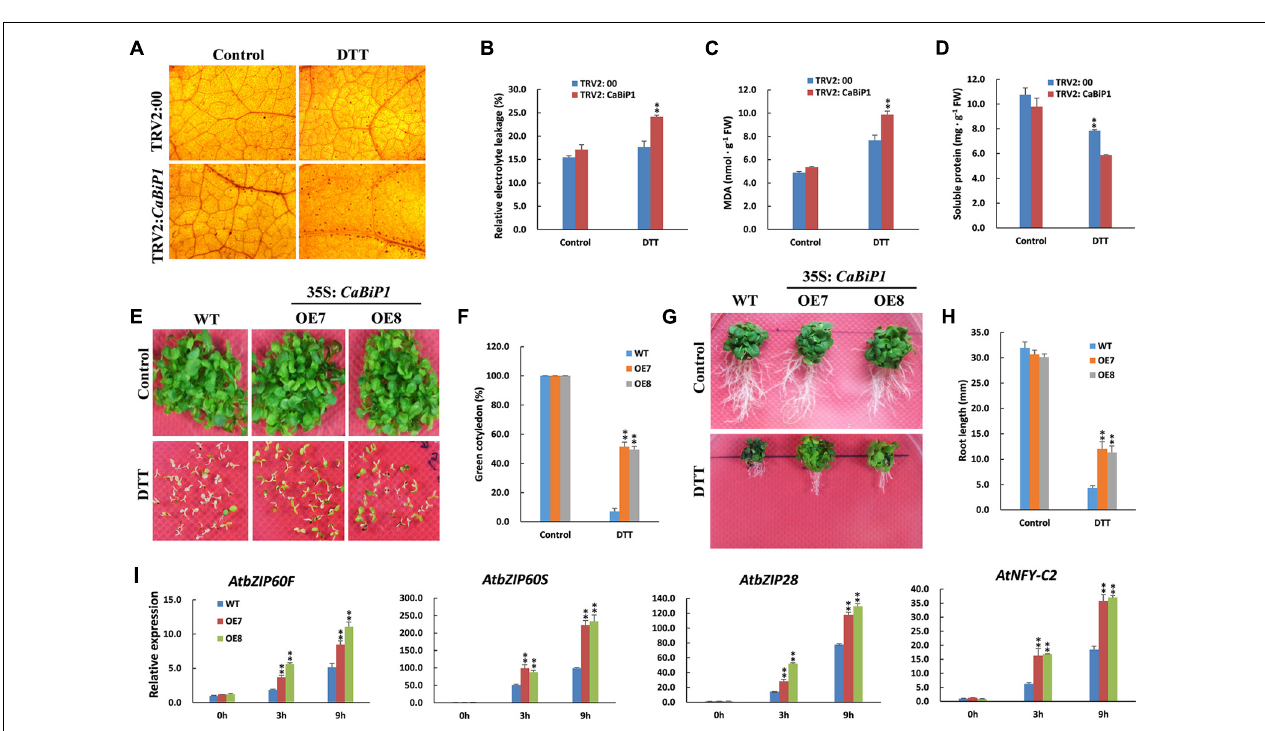
FIGURE 6 | Altered ER stress tolerance in CaBiP1 -silenced and CaBiP1 -overexpressing plants. (A–D) H 2 O 2 accumulation, REL, MDA content, and soluble protein content in leaves of TRV2:00 and TRV2: CaBiP1 pepper seedlings grown under ER stress induced by spraying 30 mM DTT for 24 h. Spraying with distilled water was performed on control plants. (E,F) Establishment of WT and CaBiP1- OE Arabidopsis seedling under ER stress conditions induced by 3 mM DTT. The percentage of seedlings with green cotyledons was calculated at the14th day after sowing. (G,H) Root growth of 5-day-old WT and transgenic Arabidopsis seedlings exposed to 2 mM DTT for 15 days. (I) Expression analysis of ER stress-responsive genes in WT and CaBiP1 -OE lines sprayed with 30 mM DTT for the designed time duration. AtActin2 was used as the internal control. Data are the mean ± standard deviation from three biological replicates. Statistical significance is indicated by a single asterisk ( p < 0.05) and a double asterisk ( p < 0.01) based on the results of the Student’s t